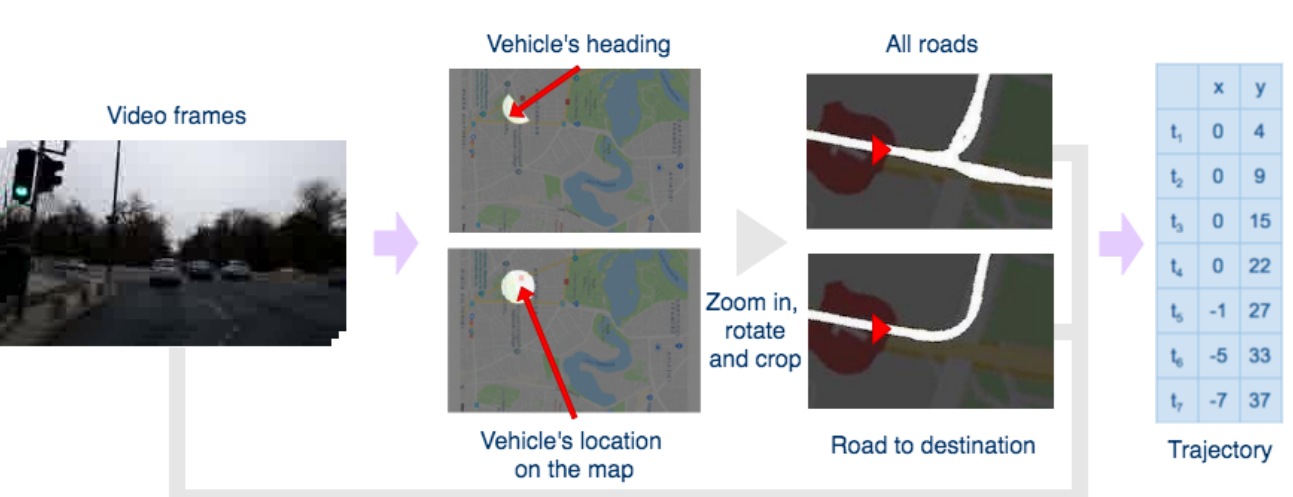
Figure 1. The high-level structure of the system. The first ConvNet module learns to predict the location and heading on the map by an image segmentation-based approach. Road map segments are cropped around the location, one showing all directions, and the other one only the intended route, conditioned on the destination. From road map crops and video frames, the second model predicts the navigation trajectory for the next seven seconds, which is also conditioned on the final destination. The trajectory estimation task becomes very interesting and useful especially in intersections with several possible